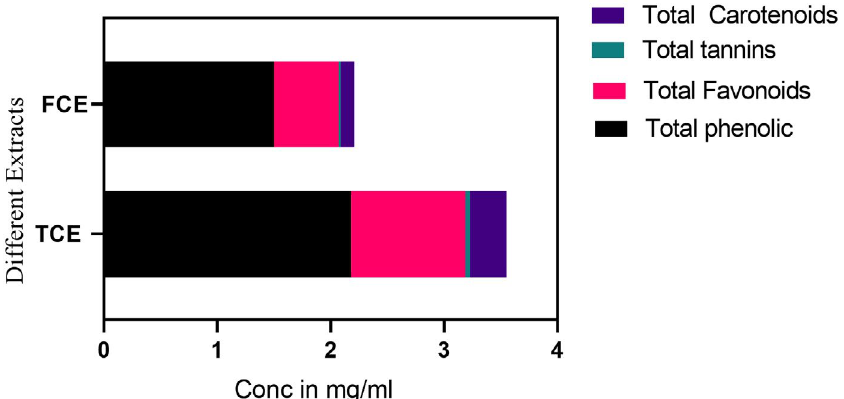
Fig. 2. The phytochemical analysis of total culture extract (TCE) and free cell extract (FCE) for total phenolics, total flavonoids, total tannic acids and total carotenoids.